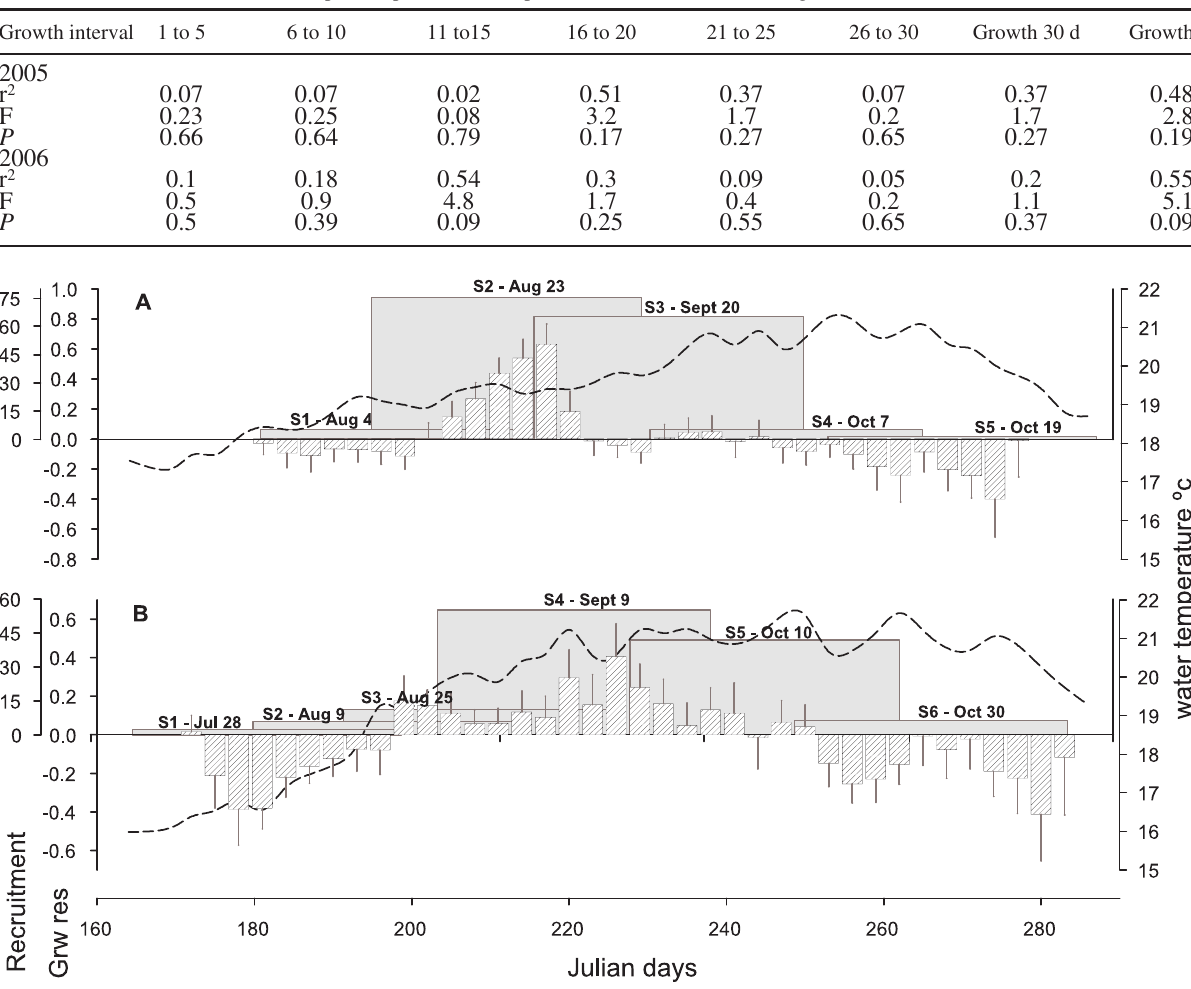
Table 3. – Summary of linear regressions between Recruitment (response variable) and larval growth over 5-day intervals during the first 30 days in the plankton, between average growth during the first 30 days in plankton (Growth 30d) and between average growth from hatch to settlement (Growth) from Coris julis recruits collected over two recruitment seasons at Varadouro (Faial Island). Correction of P values for multiple comparison are not present since all P values are larger than